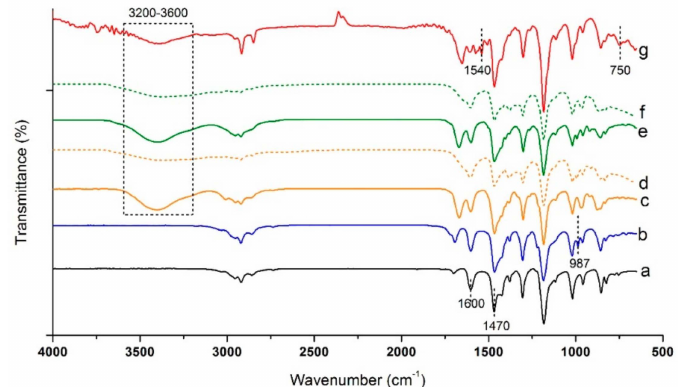
Figure 3. FTIR spectra of ( a ) PPO, ( b ) BrPPO, ( c ) PPO–TMA, ( d ) PPO–TMA after 150 h soaking in KOH, 7 M ( e ) PPO–MPY, and ( f ) PPO–MPY after 150 h soaking in KOH, 7 M, and ( g ) PPO–MIM. The broad peak shown in the dash line frame is attributed to O–H stretching of the water molecules absorbed into the samples due to their increased hydrophilicity after